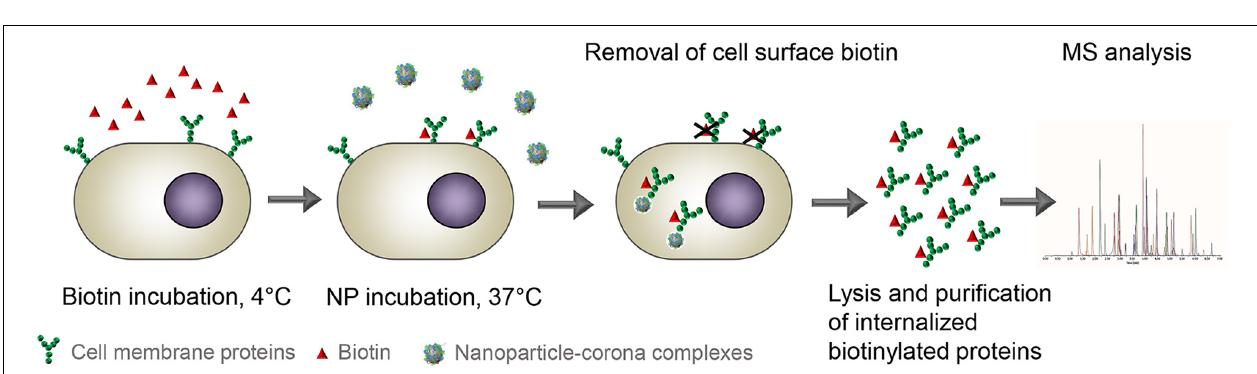
FIGURE 5 | Schematic illustration of the isolation of biotinylated cell surface proteins and the subsequent pull-down of proteins interacting with nanoparticle-corona complexes. First, cell surface proteins are labeled with biotin at 4 ◦ C. Next, the labeled surface proteins are purified and incubated with nanoparticle-corona complexes. Finally, cell surface proteins that are pulled-down by the nanoparticles are identified by mass spectrometry. Bewersdorff et al. (2017). Adapted from Aliyandi et al. (unpublished).